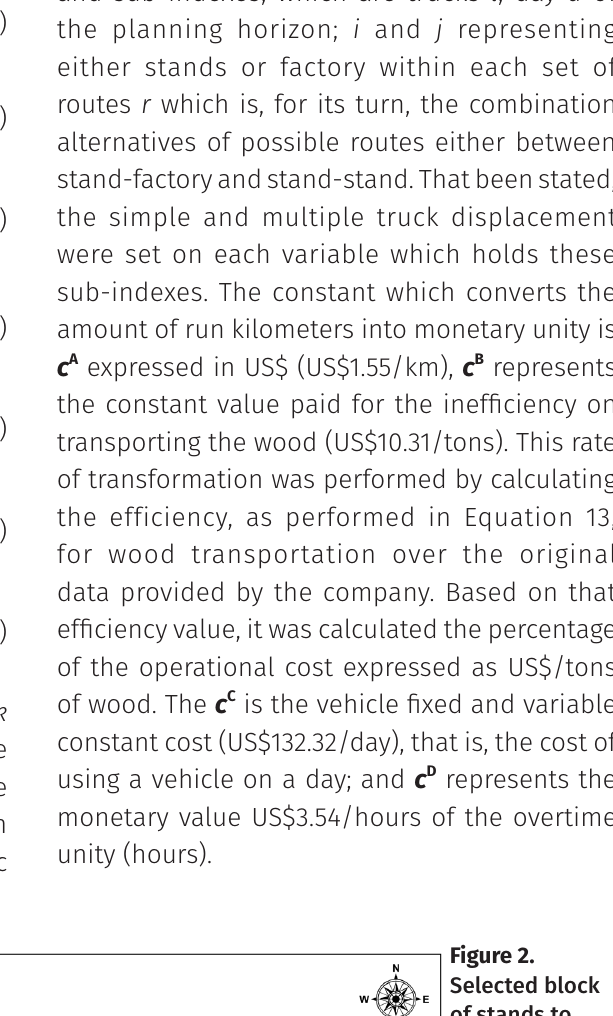
Figure 2. Selected block of stands to transportation